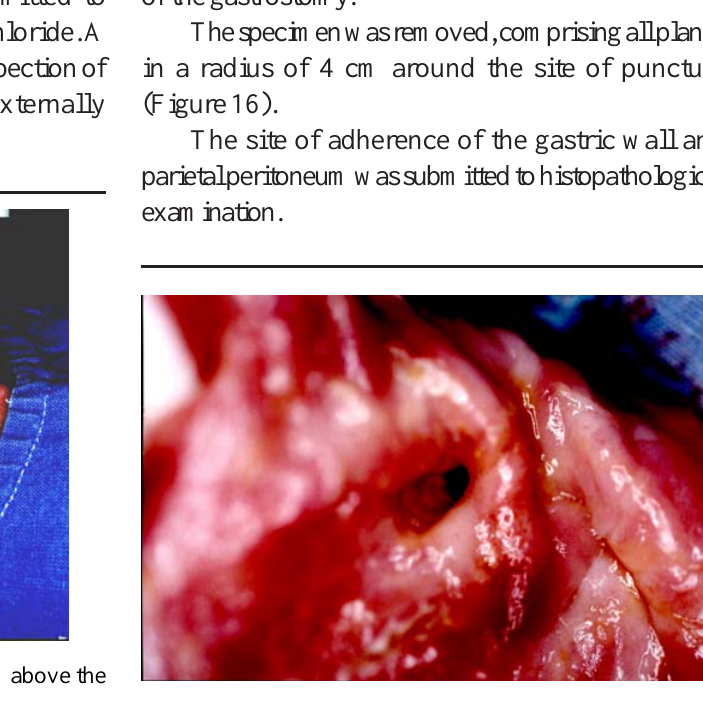
FIGURE 16 - Gastrotomy specimen is removed for histopatological study.